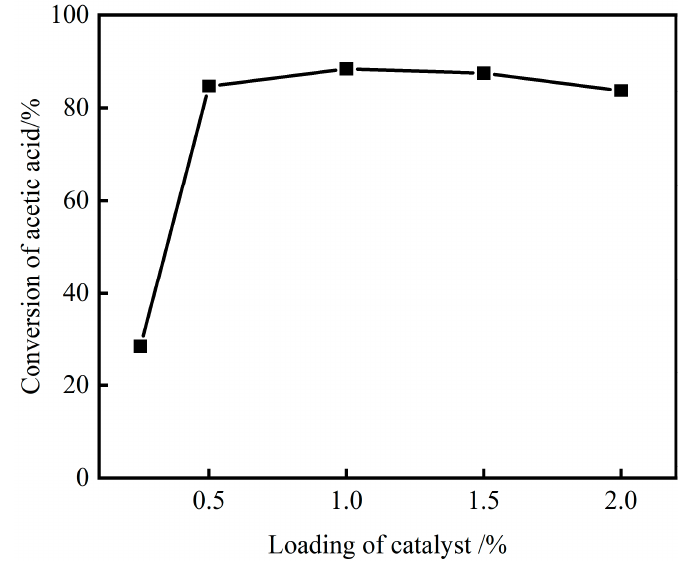
Figure 9. The effect of catalyst loading on the conversion rate of HOAc (reaction conditions: n EtOH :n HOAc = 6:1, 80 °C, 3 h, 640 rpm).